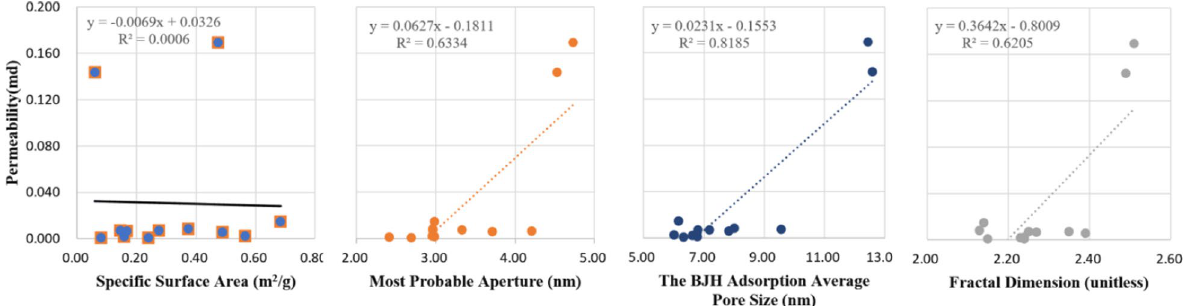
Fig. 10 Linear regression relationship between pore structure and